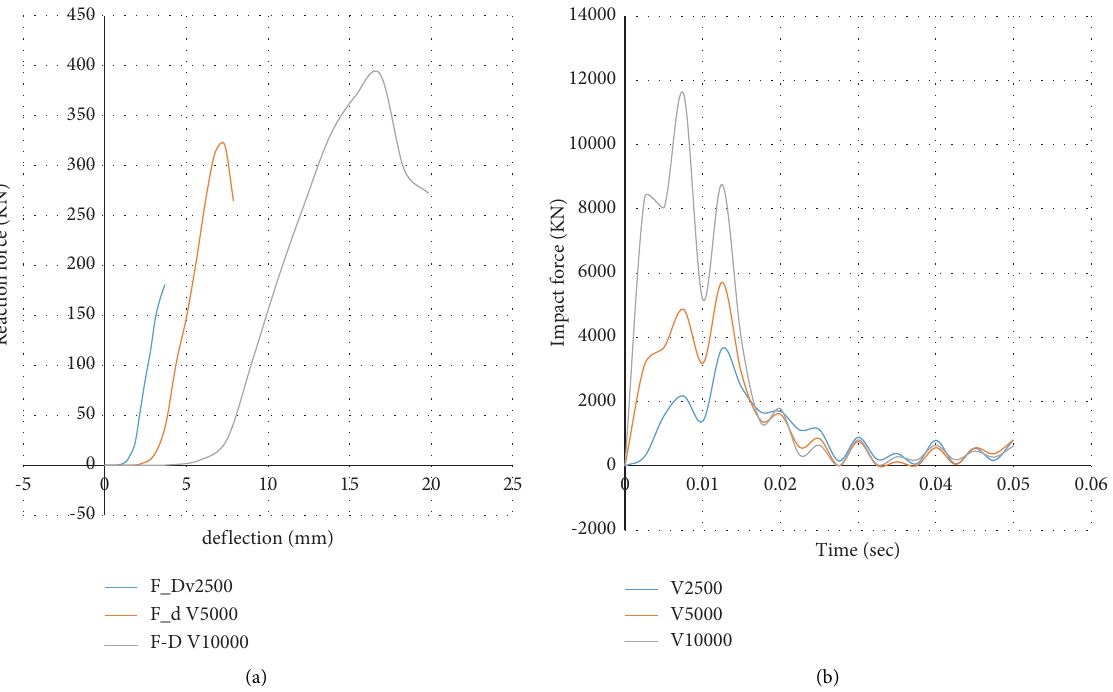
Figure 7: (a): Reaction force vs defection curve for velocity 2.5, 5, 10 m/s. (b): Impact force vs. time curve for velocity 2.5, 5, 10 m/s. Table 5: Impact force analysis result at diferent velocity. Peak Time impact force (KN)